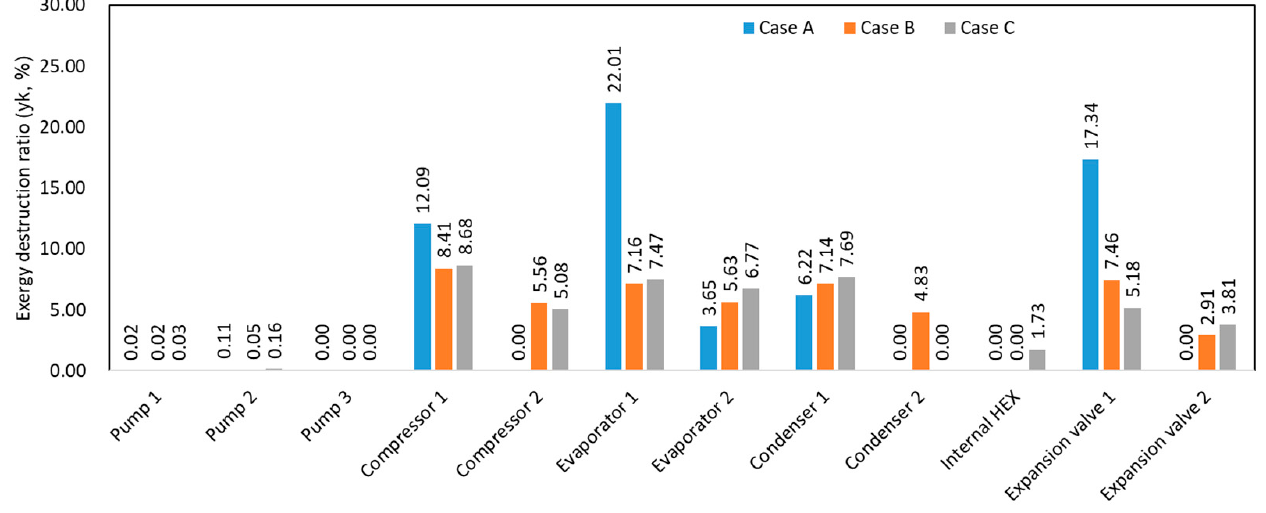
Figure 9. Exergy destruction